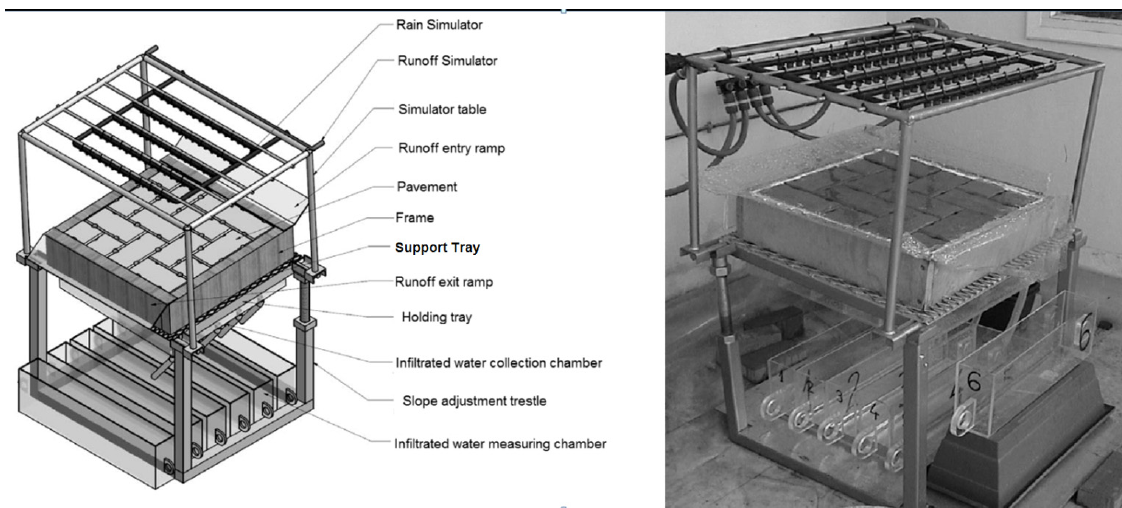
Figure 1. Detail of Cantabrian Fixed Infiltrometer [50].